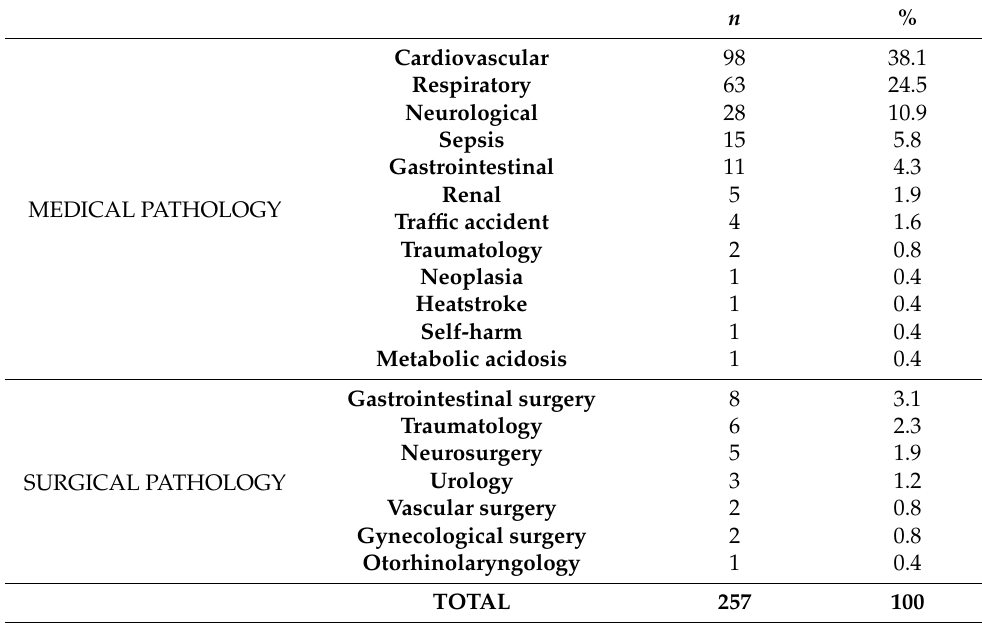
Table 2. Admission Diagnosis in ICU.